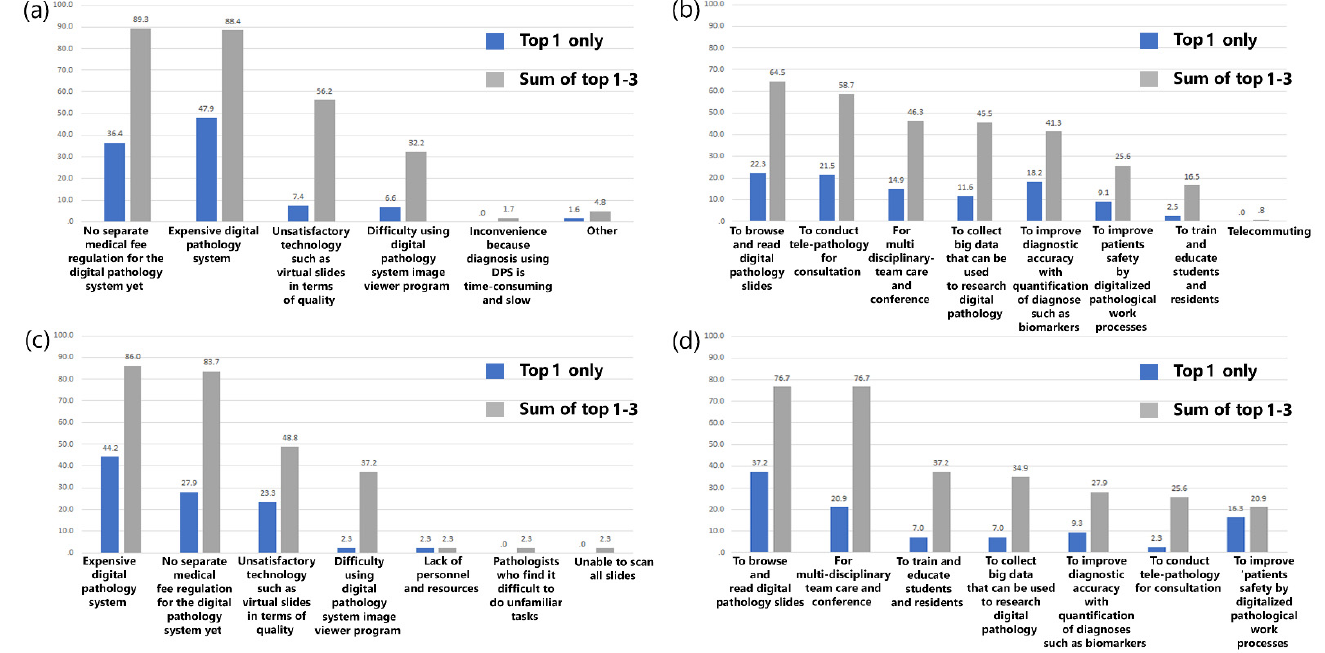
Figure 2. Hurdles to DPS introduction according to DPS experience levels. ( a ) Expected hurdles when introducing a DPS. In the case of pathologists without experience using a DPS, the most considerable obstacle to introducing a DPS was the ‘lack of separate medical fee regulation for DPSs’ and ‘expensive DPSs’. ( b ) Expected use when introducing a DPS. In the